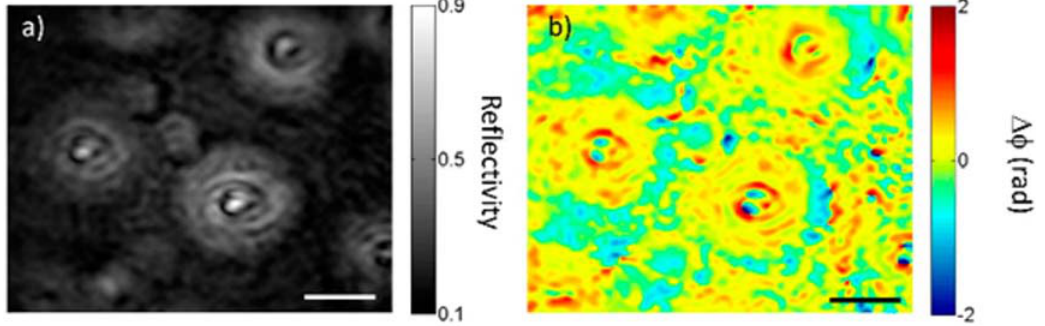
Figure 3. ( a ) Experimental determination of ERI of nanofluids using total internal reflection (TIR) and ( b ) correlation of TIR with normalized SPR reflectance R for varying concentrations [4].